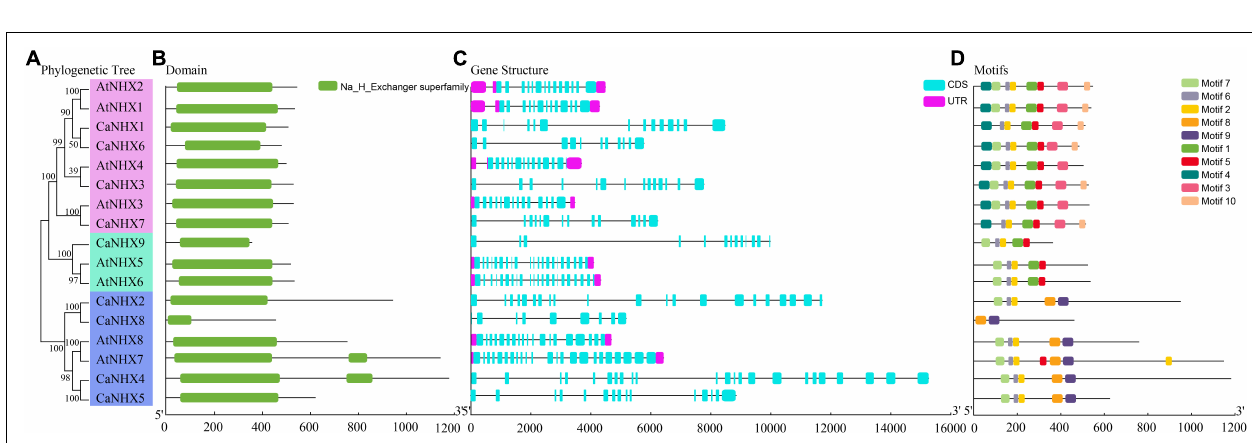
Frontiers in Genetics |